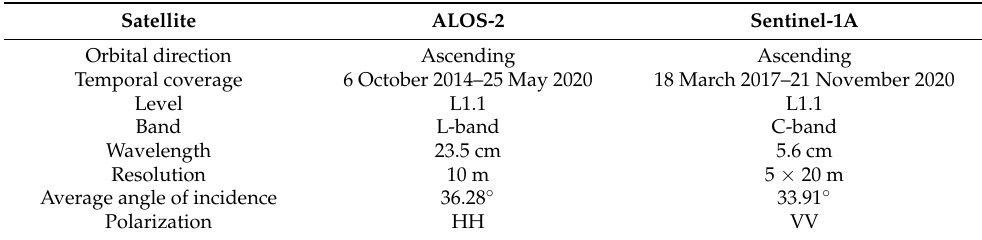
Table 1. Basic information of the ALOS-2 and Sentinel-1A images. Satellite ALOS-2 Orbital direction